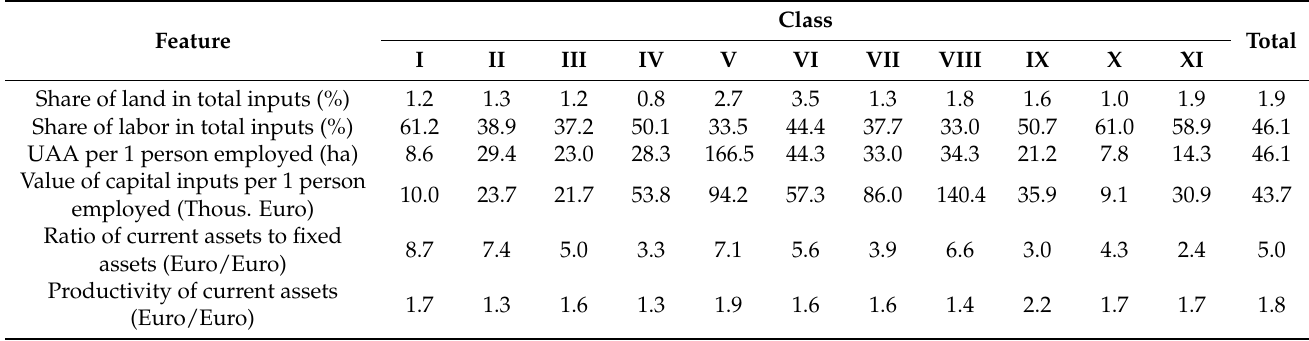
Table 4. Mean intraclass features describing production potential of the agricultural sector in the EU countries and the USA.